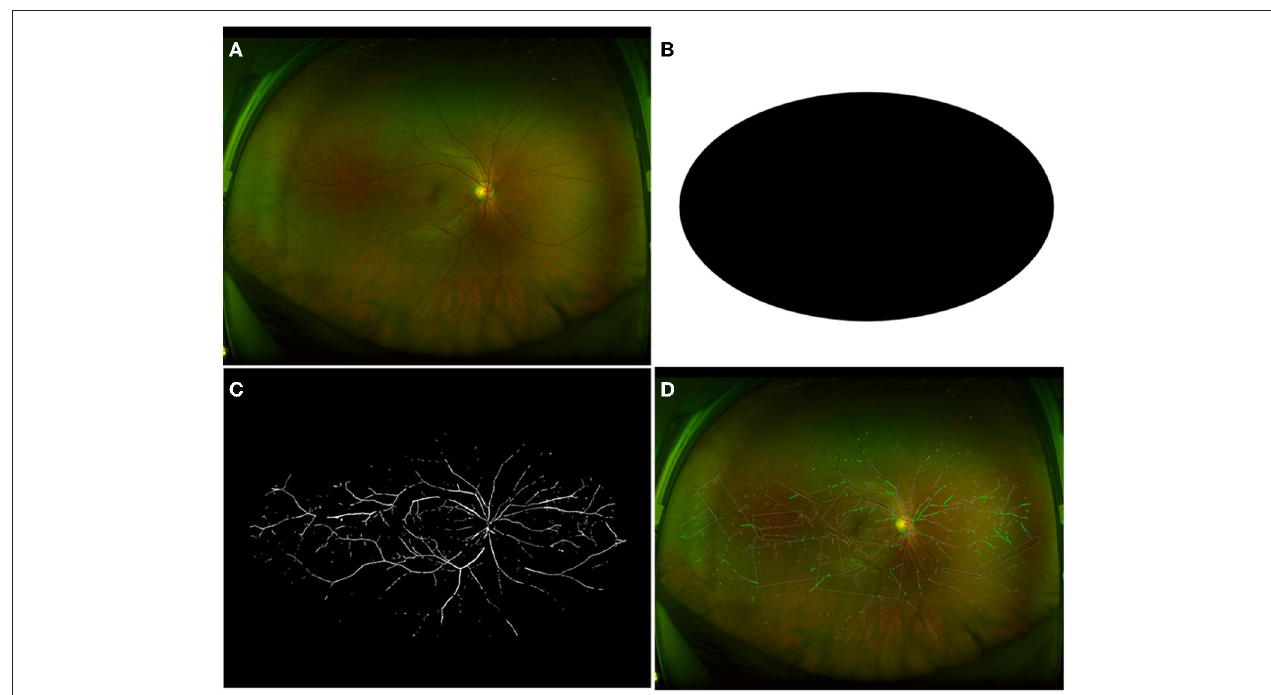
FIGURE 1 | Image process of HC group with general cover. (A) The raw retinal image of one participant from the HC group. (B) Displayed general cover to get rid of inferences of eyelid and eyelash. (C) Extracted vessels as a binary image to compute vessel density. (D) The calculation for vessel caliber and tortuosity. HC, healthy